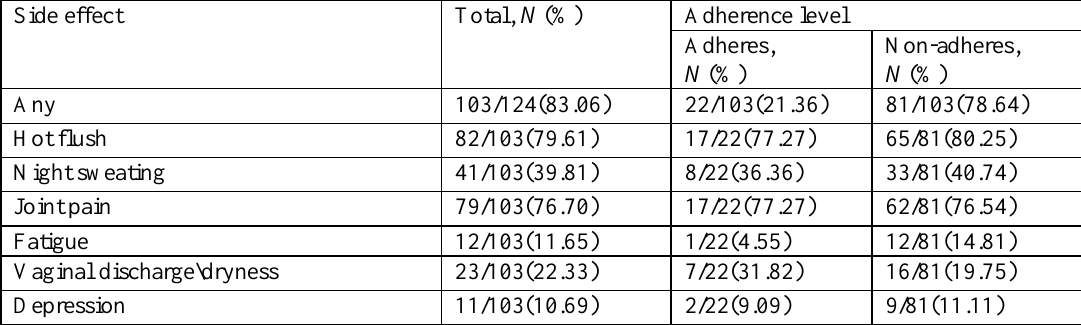
Table 3. Number (N) and percentage (%) reporting side effects, for total patients as well as for adheres and non-adheres